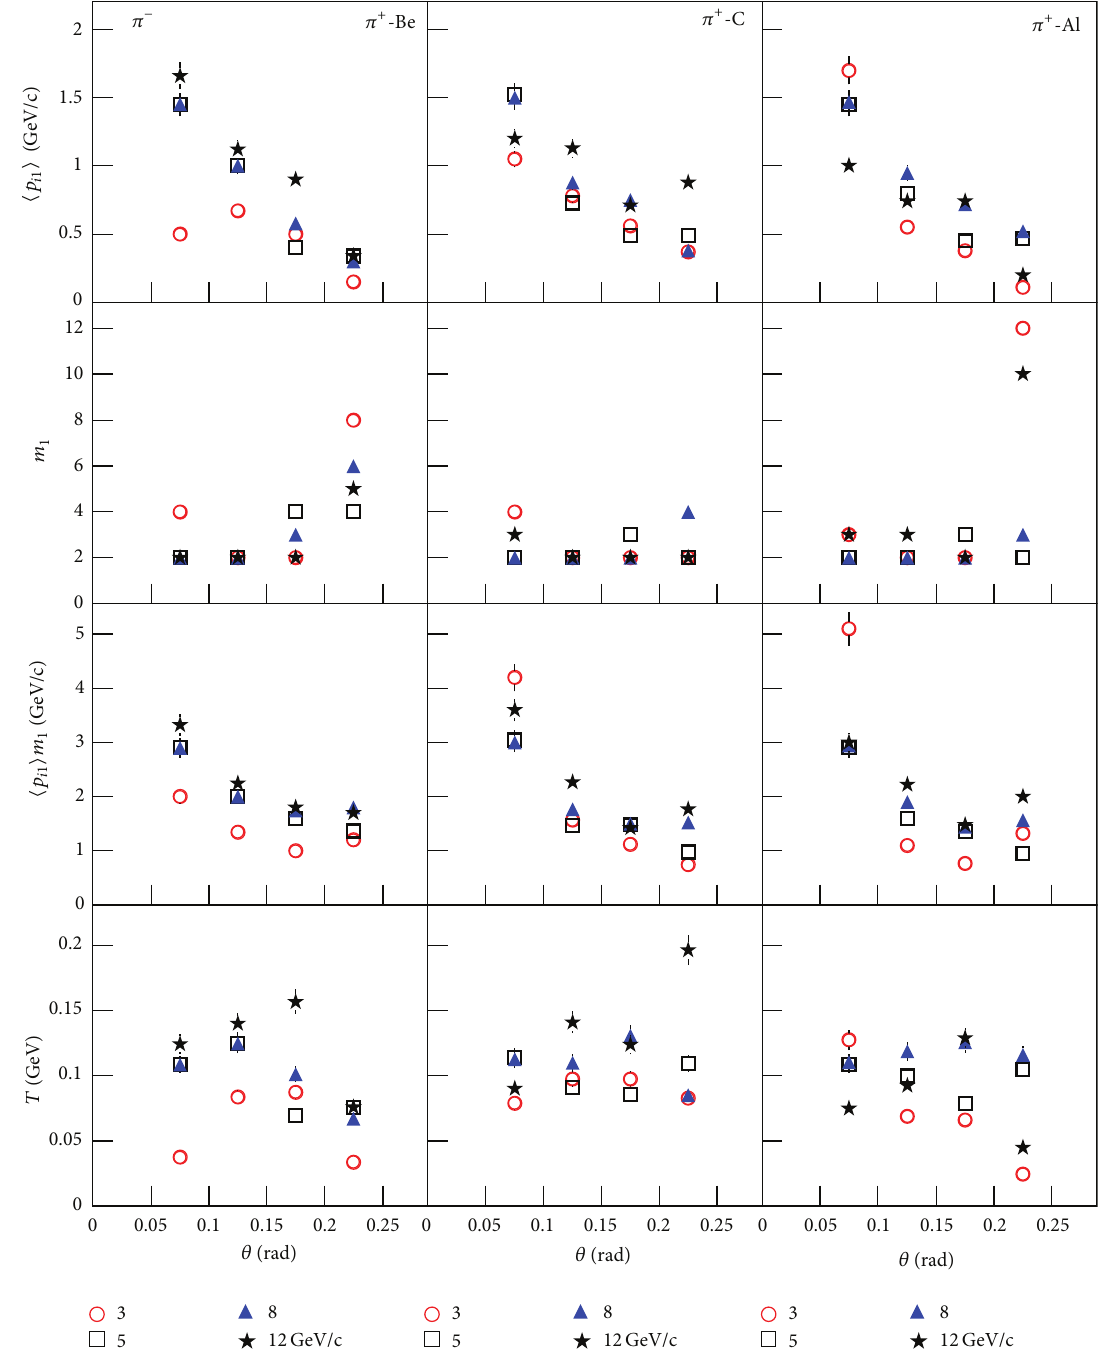
Figure 16: The same as Figure 13, but showing the results for 𝜋 − produced in 𝜋 + -Be, C, and Al interactions. The parameter values for targets Be, C, and Al are taken from Figures 4, 8, and 12, respectively.